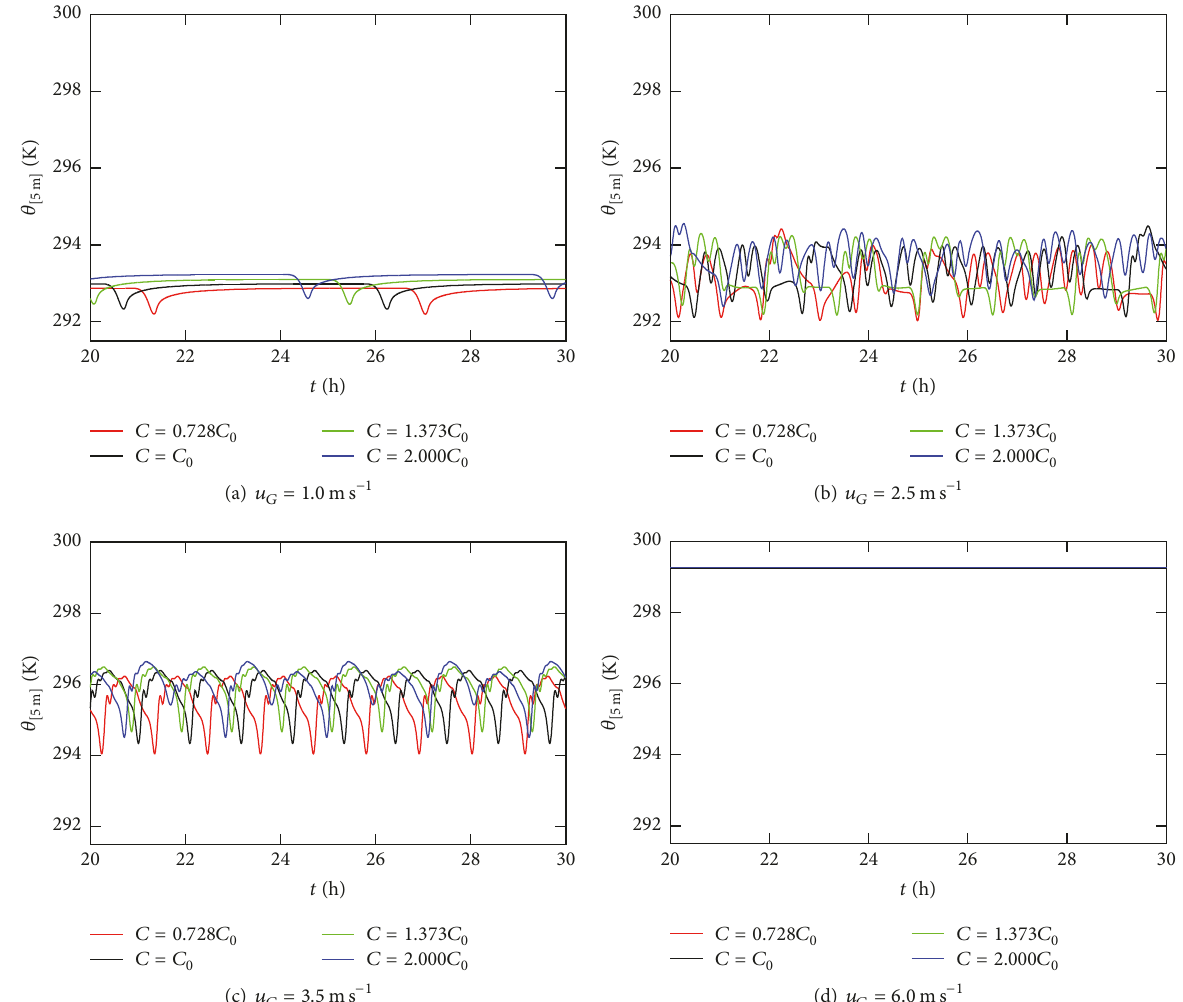
Figure 1: Time series of temperature at 5 m, with different atmospheric concentrations of CO 2 (indicated in the legend) for different values of the mechanical forcing, in the title of each